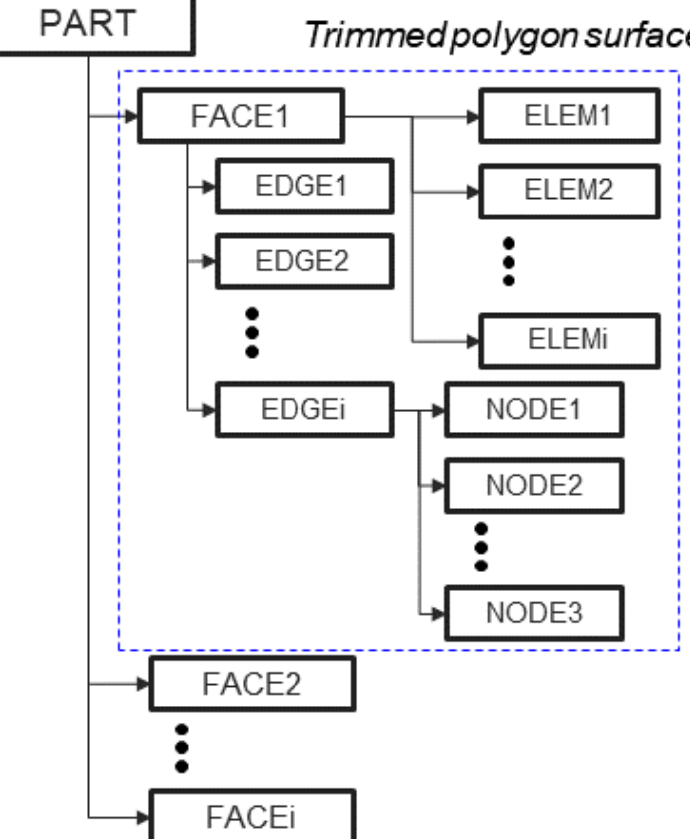
Figure 6. Data structure for parts.